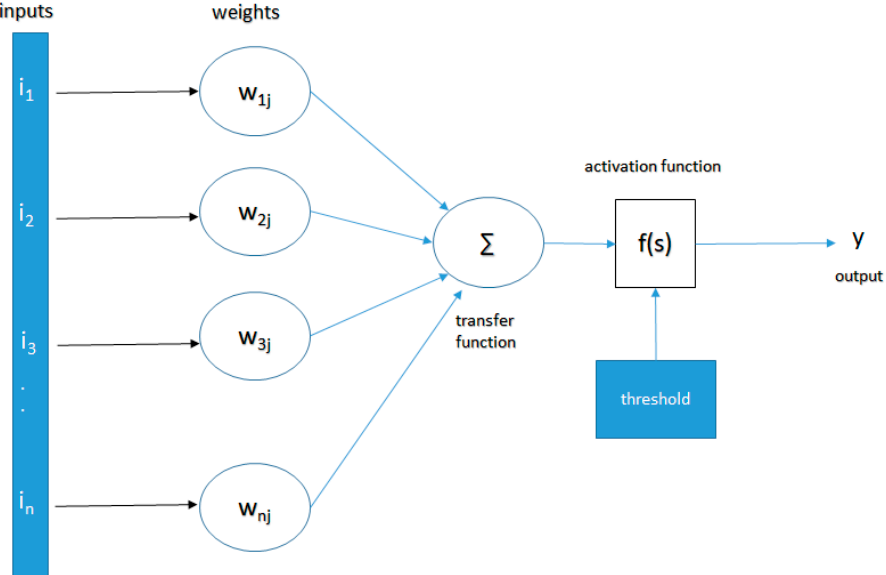
Figure 2. The structure of an artificial neuron.